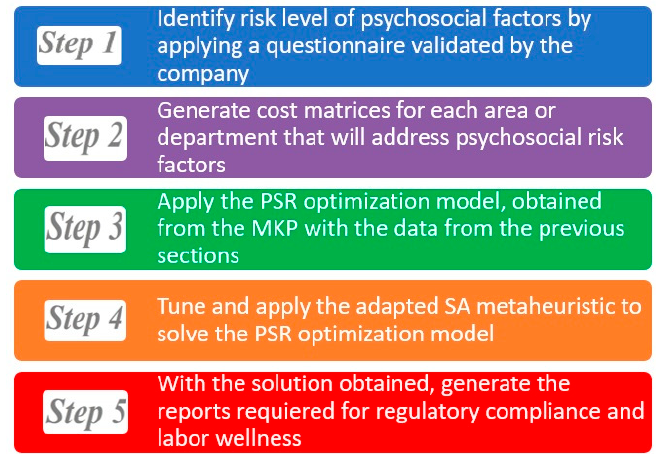
Figure 2. Methodology stages for optimizing the attention of PSR factors.